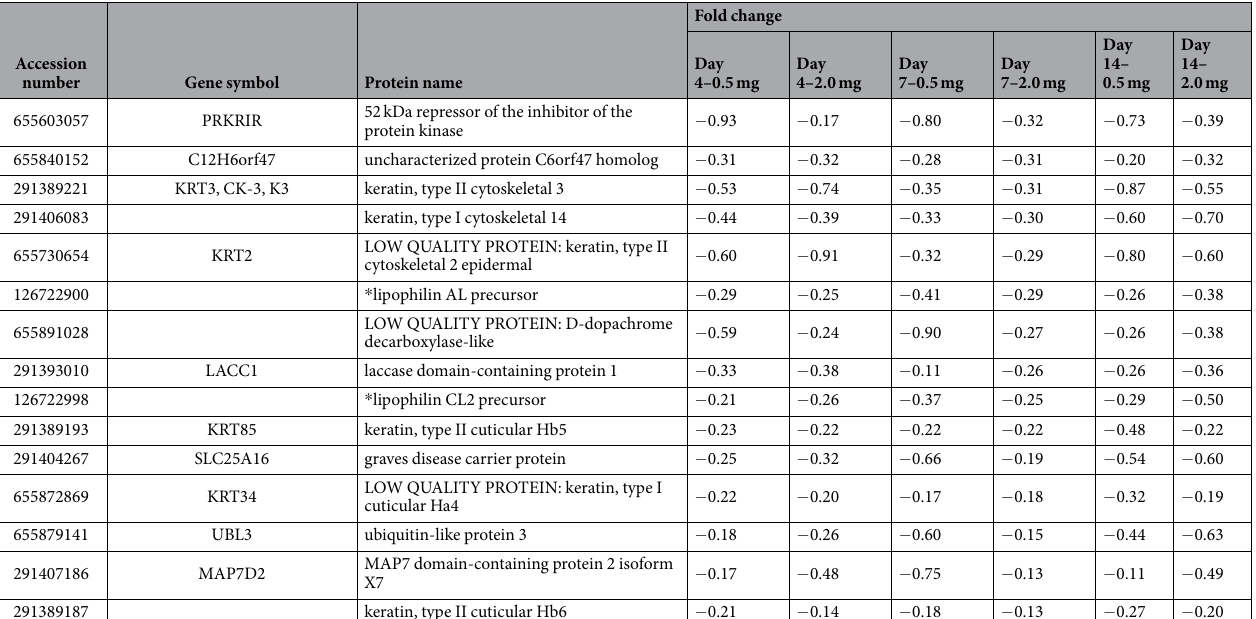
Table 2. Significantly down-regulated proteins after intravitreal injection of conbercept. * Means the proteins are not predicted proteins. − Means down-regulation.